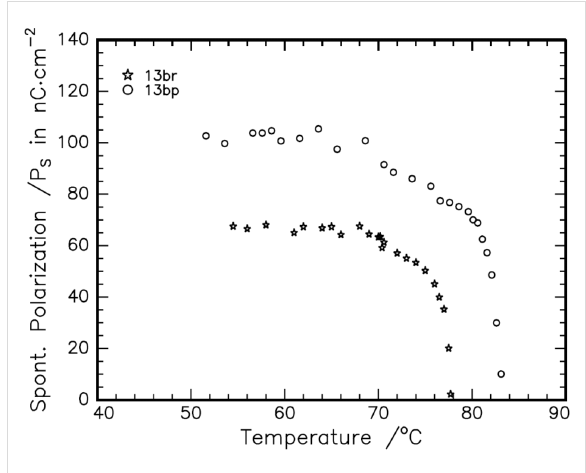
Figure 3: Temperature dependant spontaneous polarisation in 13bp and 13br .